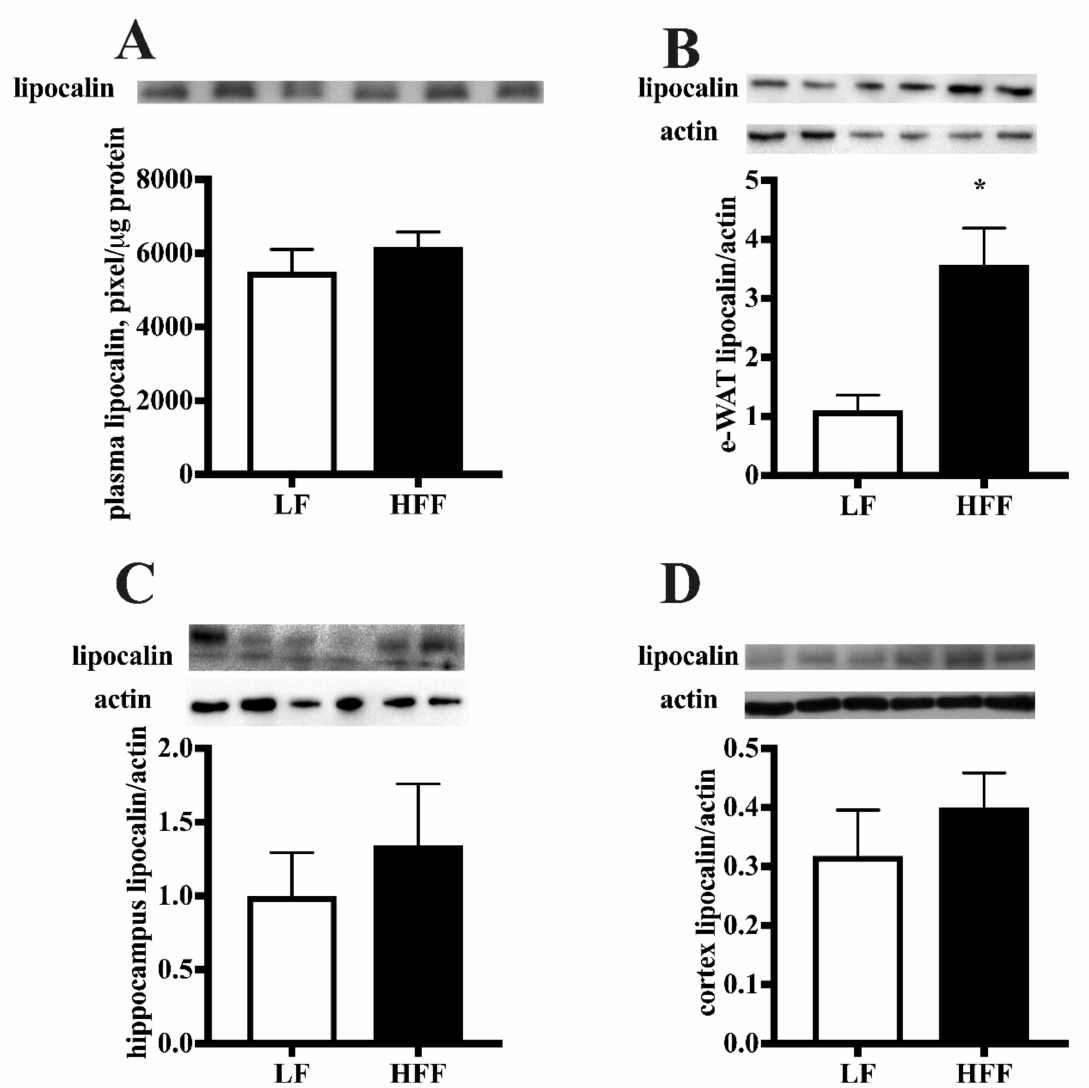
Figure 5. Protein content (with representative western blot) of lipocalin in plasma ( A ), epididymal white adipose tissue (e-WAT) ( B ), hippocampus ( C ), and frontal cortex ( D ) from middle-aged rats fed low fat (LF) or high fat-high fructose (HFF) diet for four weeks. Values are the means ± SEM of eight rats. * p < 0.05 compared to low-fat diet (two-tailed Student’s